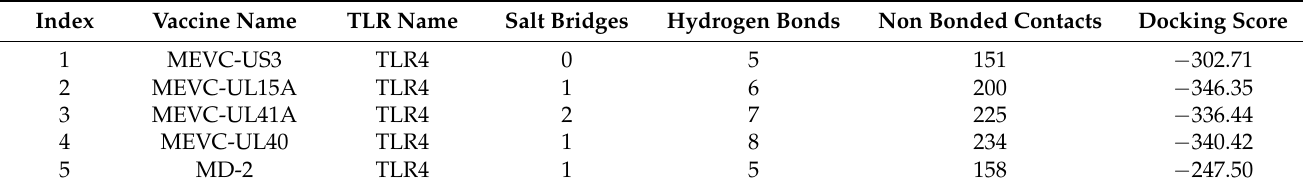
Table 4. Represents docking scores and number of formed interactions between the designed MEVCs and human